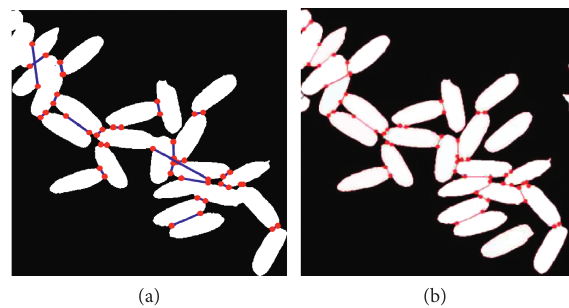
Figure 22: (a) The unimproved segmentation effect picture. (b) The improved segmentation effect picture.